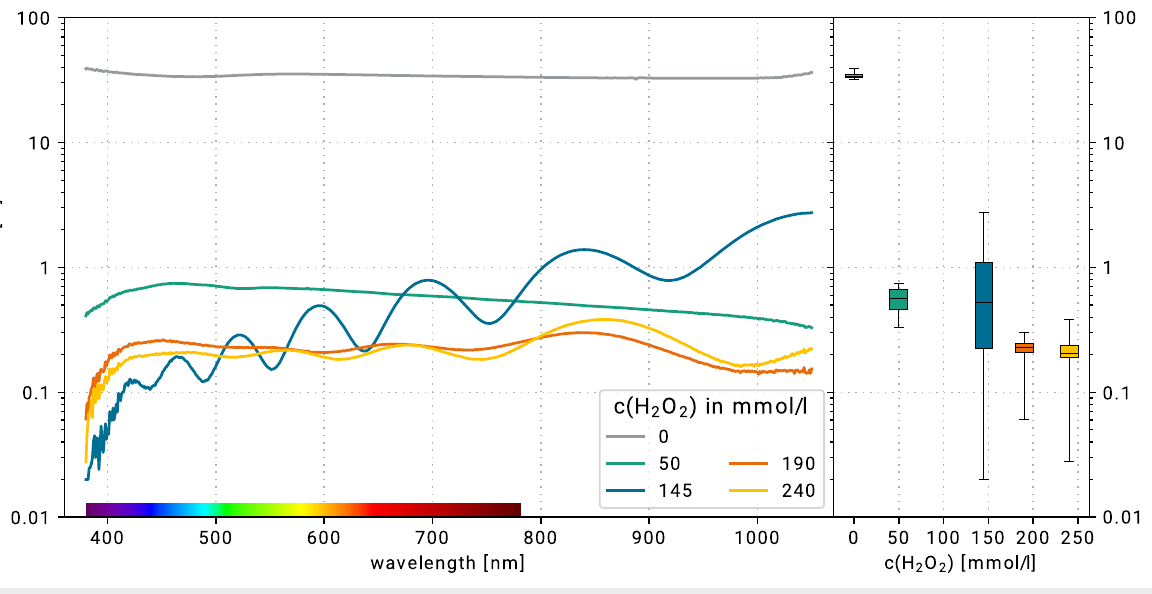
Figure 6: Measured reflectance of Au wafers after 10 min of etching in HF (1.73 mol/L)/H 2 O 2